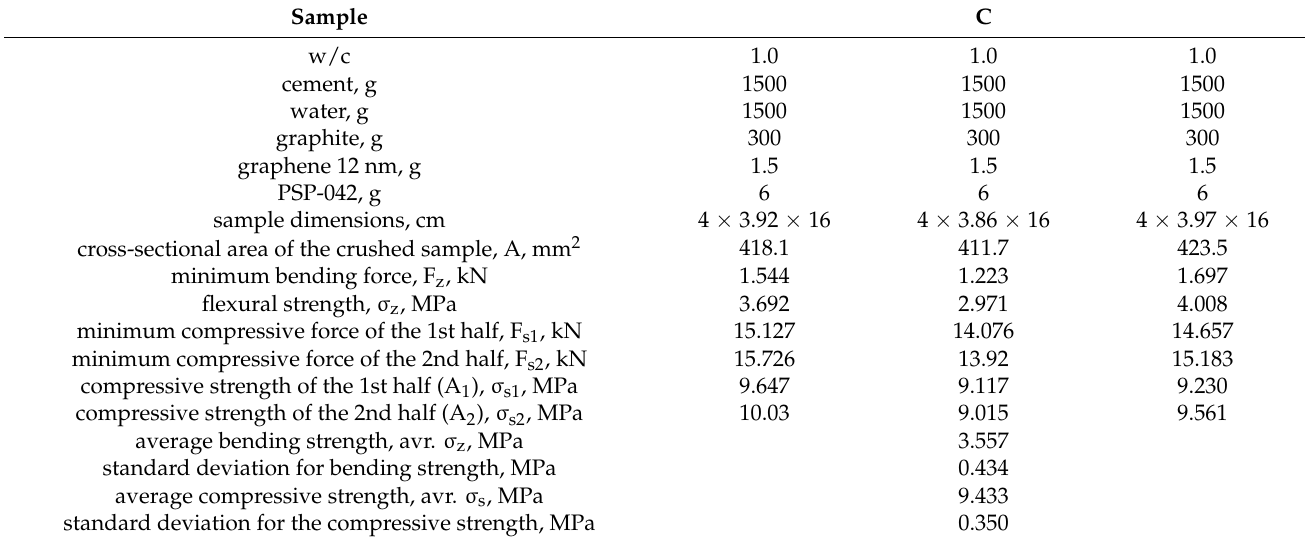
Table 4. Strength test results of the hardened sealing slurries: sample C.